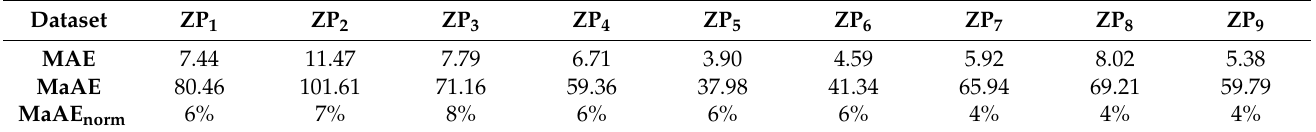
Figure 15. Simulation result using LSTM algorithm for measurements without anomaly ( ZP 1 ). Table 4. Simulation results with the LSTM algorithm for datasets ZP 1 . . . , ZP 9 .